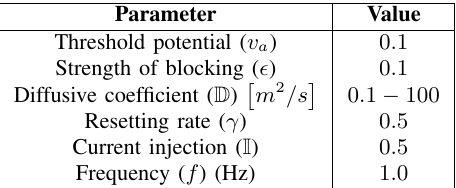
TABLE II: Table of the parameters associated with the FitzHugh-Nagumo electrophysiology